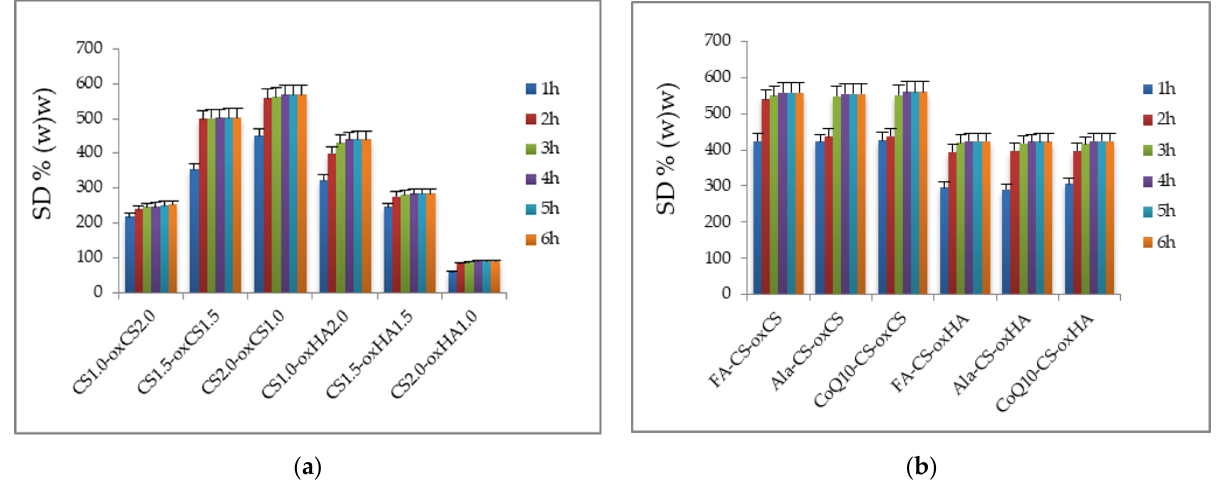
Figure 8. The SD (%) of CS-oxCS/oxHA ( a ) and API-CS-oxCS/oxHA ( b ) hydrogels.